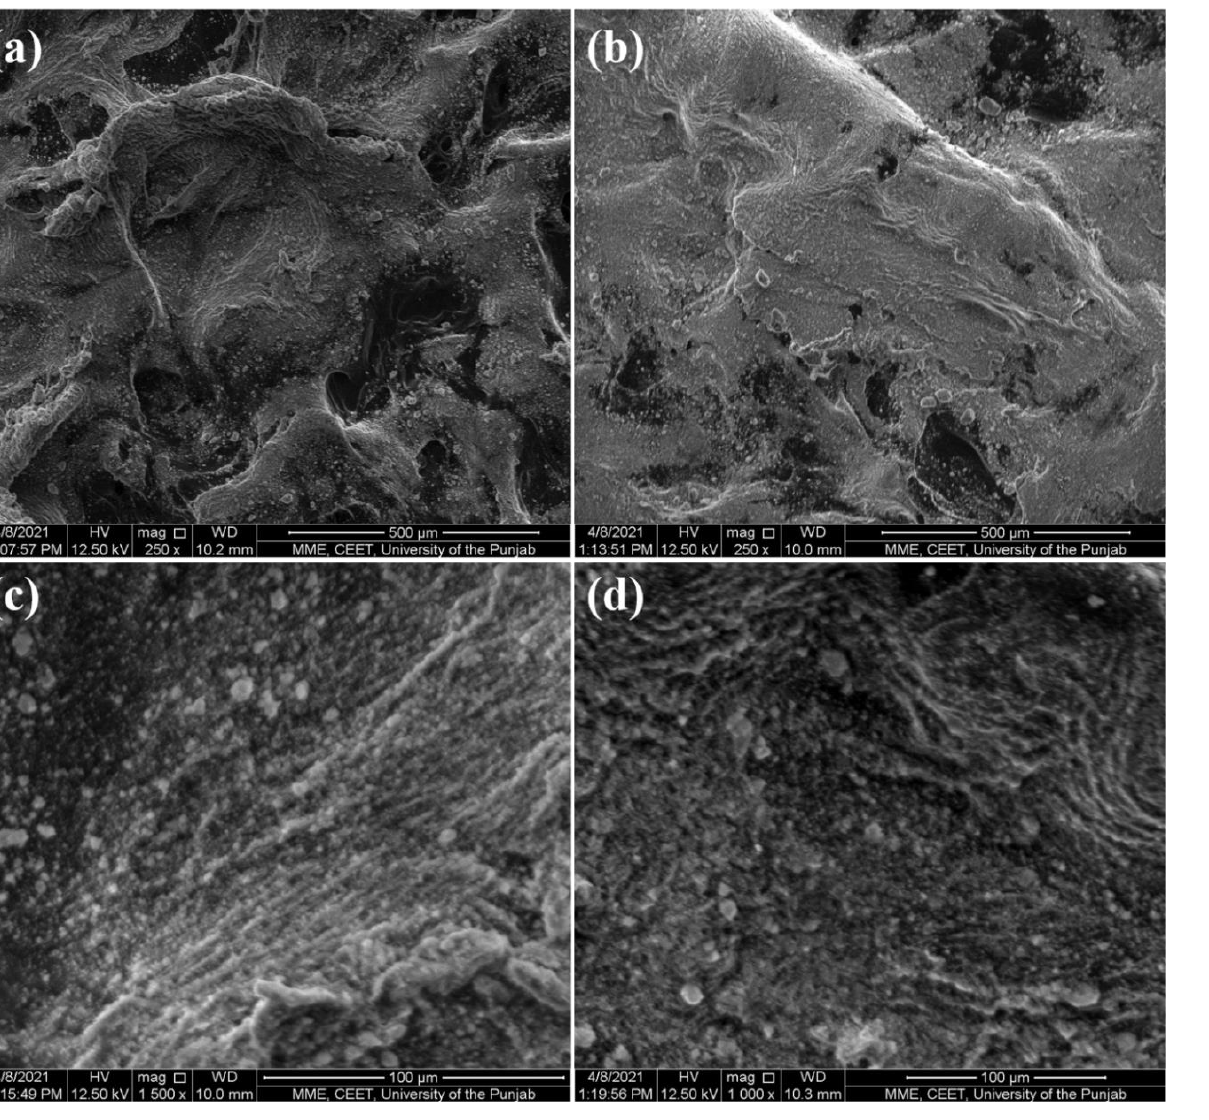
Figure 2. SEM images of ( a ) Bi@PMOS, ( b ) Ce@PMOS, ( c ) Bi 2 O 3 , and ( d ) CeO 2